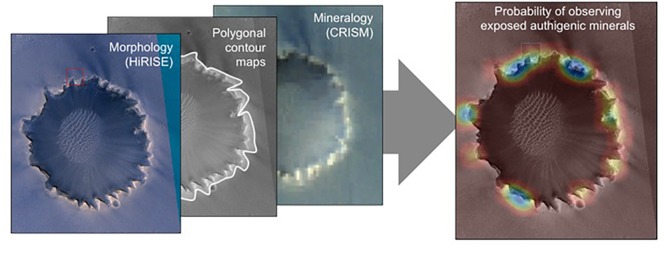
Conceptual illustration of integration of geo-registered datasets at Victoria Crater on Mars to produce map overlays indicating the probability of target variables driving exploration and sampling decisions. In the panel at right, cool colors indicate higher probability of discovering exposed authigenic minerals at that location. Crater diameter ∼800 m across. HIRISE Credit: NASA/JPL/University of Arizona. CRISM Credit: NASA/JPL/JHUAPL.